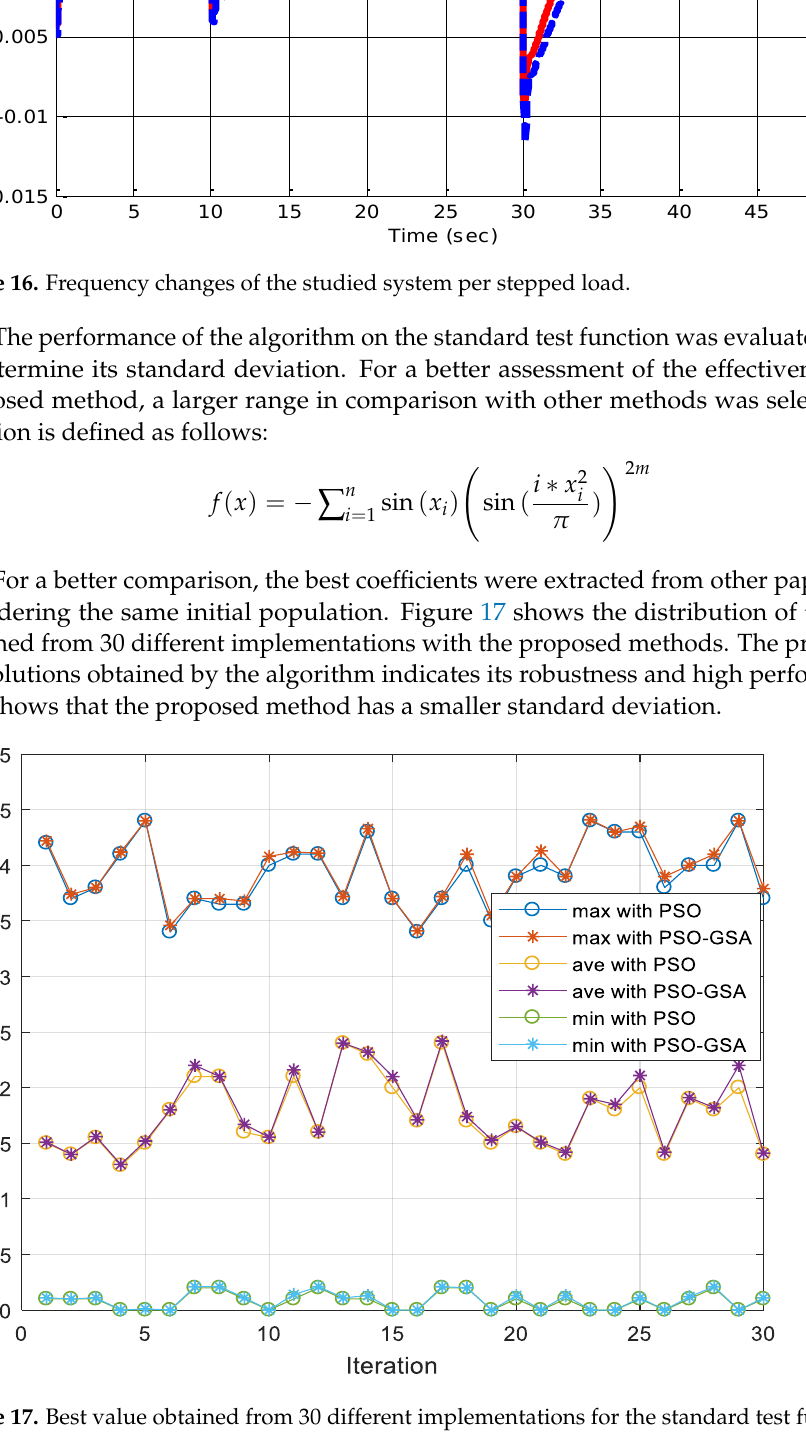
Figure 16. Frequency changes of the studied system per stepped load.